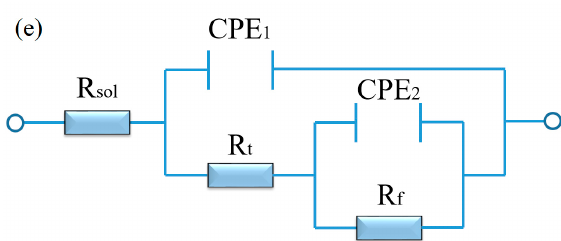
Figure 5. EIS analysis of aged Mg-3Sn and Mg-3Sn-1Ca alloys in 3.5 wt.% NaCl solution: ( a , c ) Nyquist plot, ( b , d ) Bode and Phase angle plots; The equivalent circuit ( e ) of aged Mg-3Sn and Mg-3Sn-1Ca alloys.